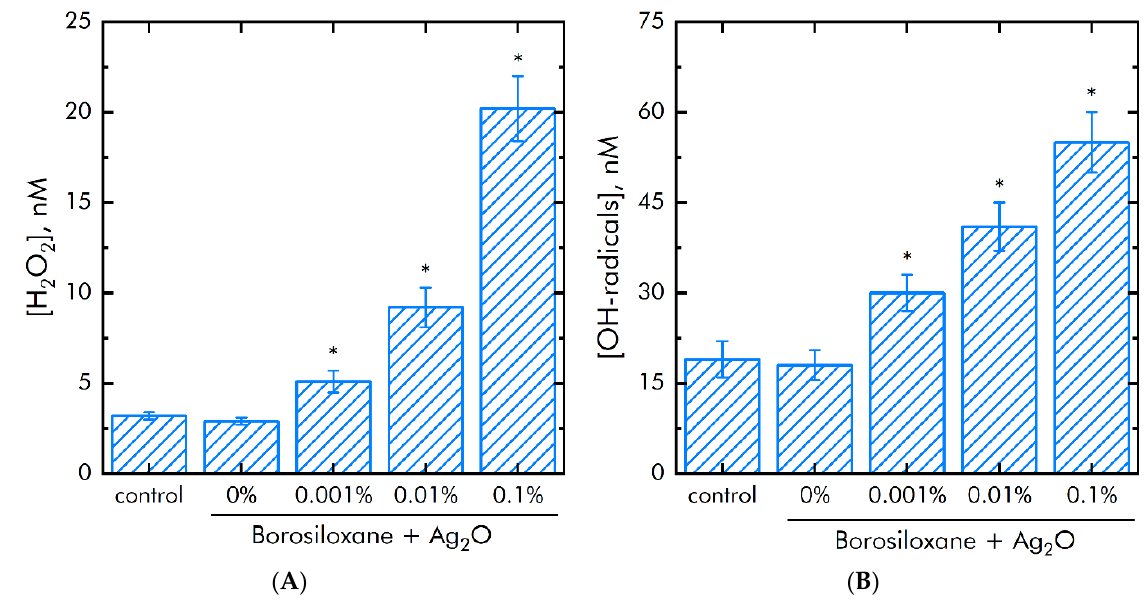
Figure 8. Influense of a BS and composition Ag 2 O NPs·BS on the generation of ROS during 2 h at 40 ℃ . ( A ) — H 2 O 2 generation. ( B ) — OH-radicals production. * — p < 0.05 vs. control. Data are shown as means ± SEMs.